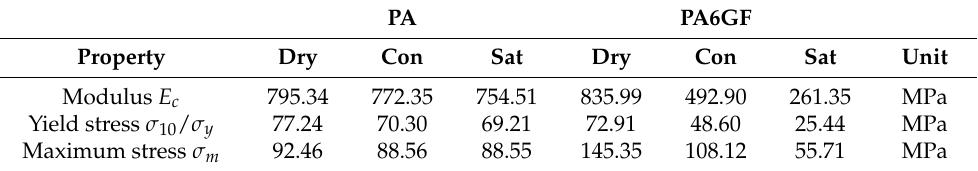
Figure 9. Stress-strain curves of dry, conditioned (con), and saturated (sat) specimens. Table 7. Results of compression tests on dry, conditioned (con), and saturated (sat) specimens.